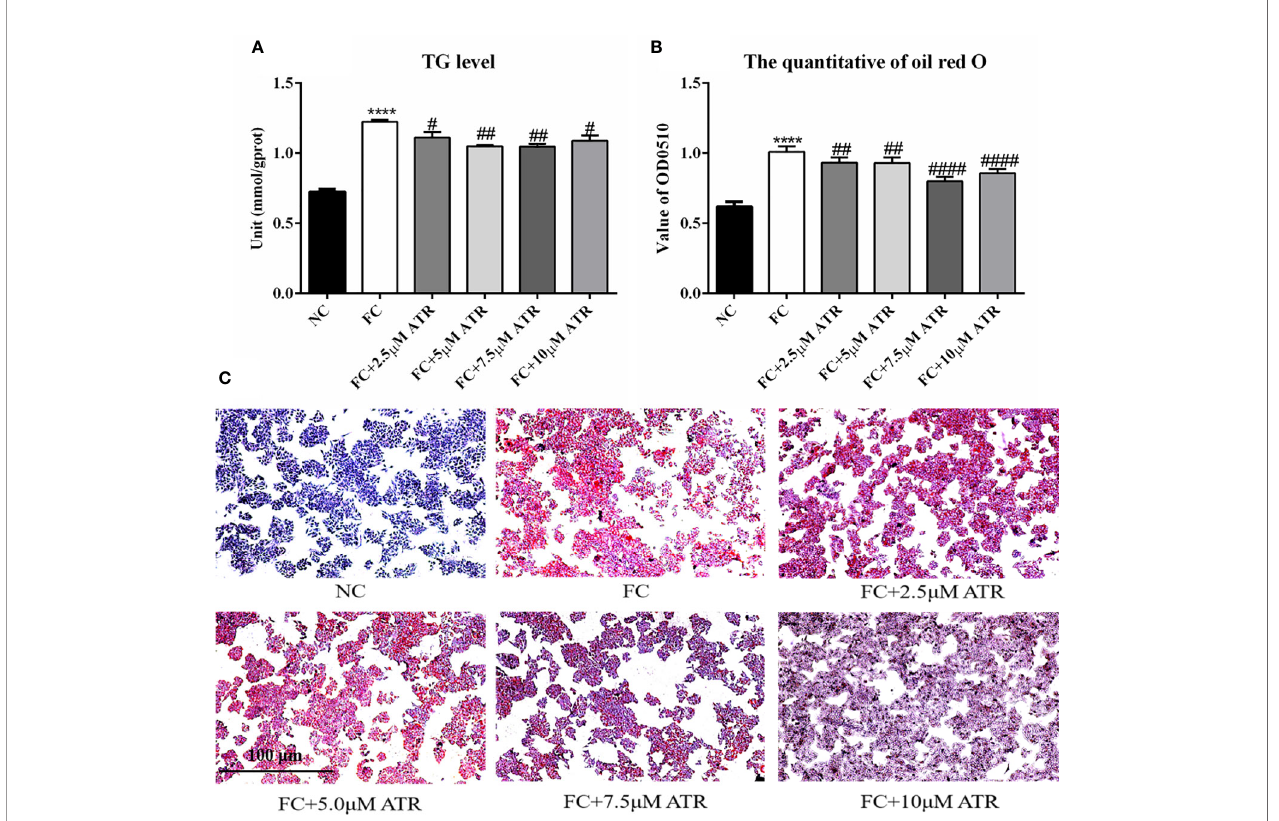
FIGURE 2 | Effect of ATR on TG level in FFA-treated HepG2 cells. (A) Changes in TG level in FFA-treated HepG2 cells. (B) Quantity of oil red O in FFA-treated HepG2 cells. (C) Images (5×) of HepG2 cells stained with oil red O. Data are expressed as mean ± SD (n=3). ****P<0.001 (*represents ATR groups compared with the control group). # P<0.05, ## P<0.01, #### P<0.001 ( # represents FC+ATR treatments compared with the FC group). NC=normal group, and FC=FFA